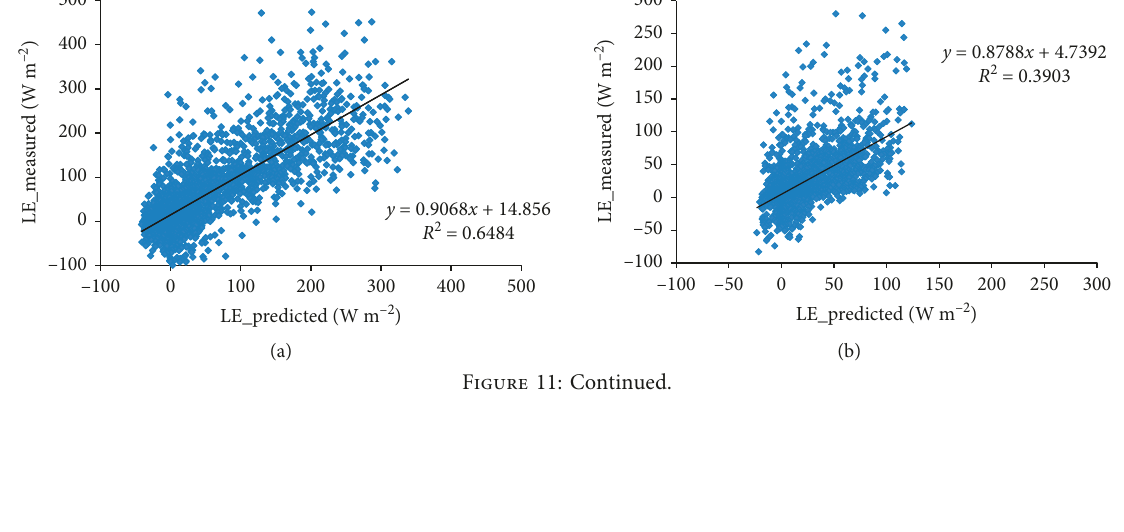
y = 0.9068 x + 14.856 R 2 = 0.6484